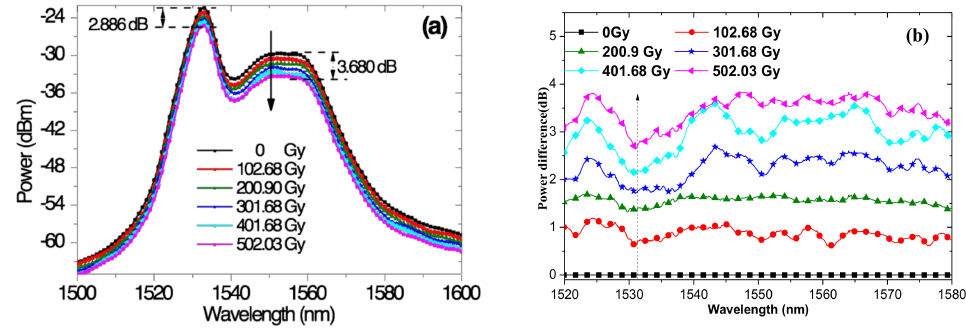
Figure 4. ( a ) Spectral evolution and ( b ) spectral variations of SFS#1 with respect to taking the zero-irradiated spectrum as the